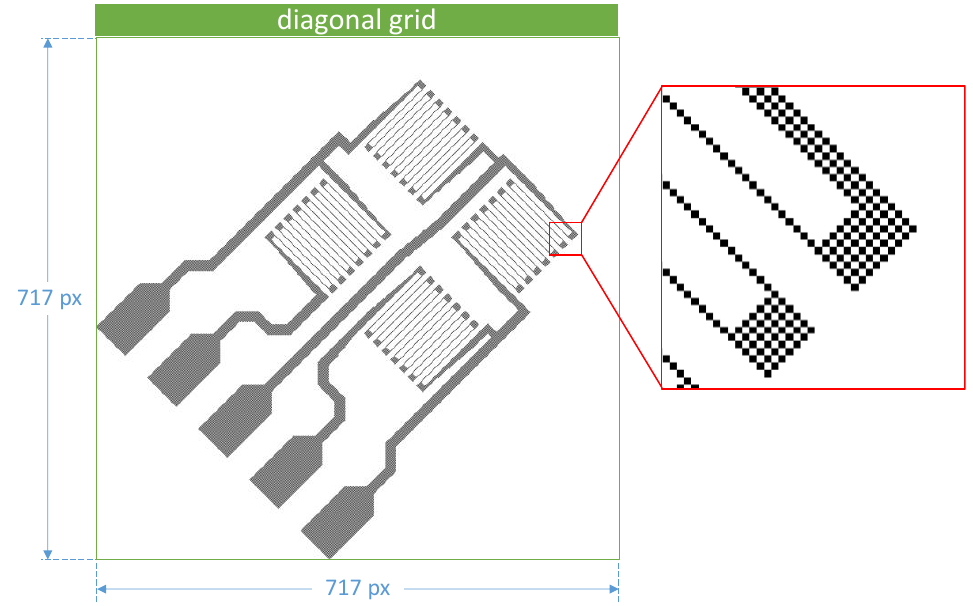
Figure 8. Print pattern according to Figure 2 rotated by 45° by using a diagonal grid.